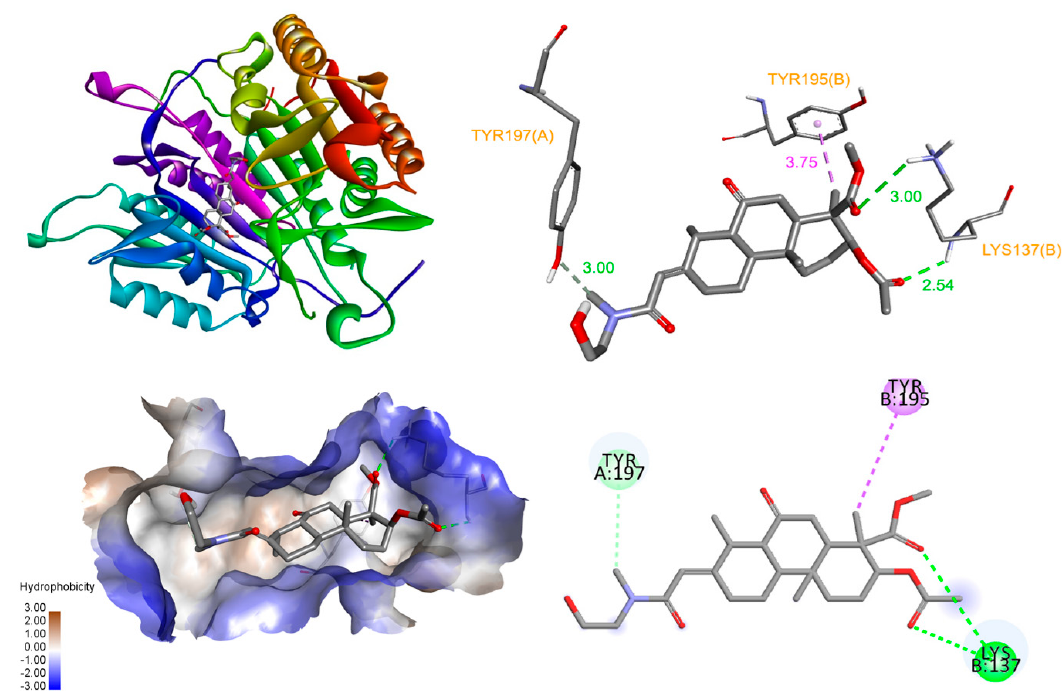
Figure 5. Interaction diagram of 3AEP with caspase-3.